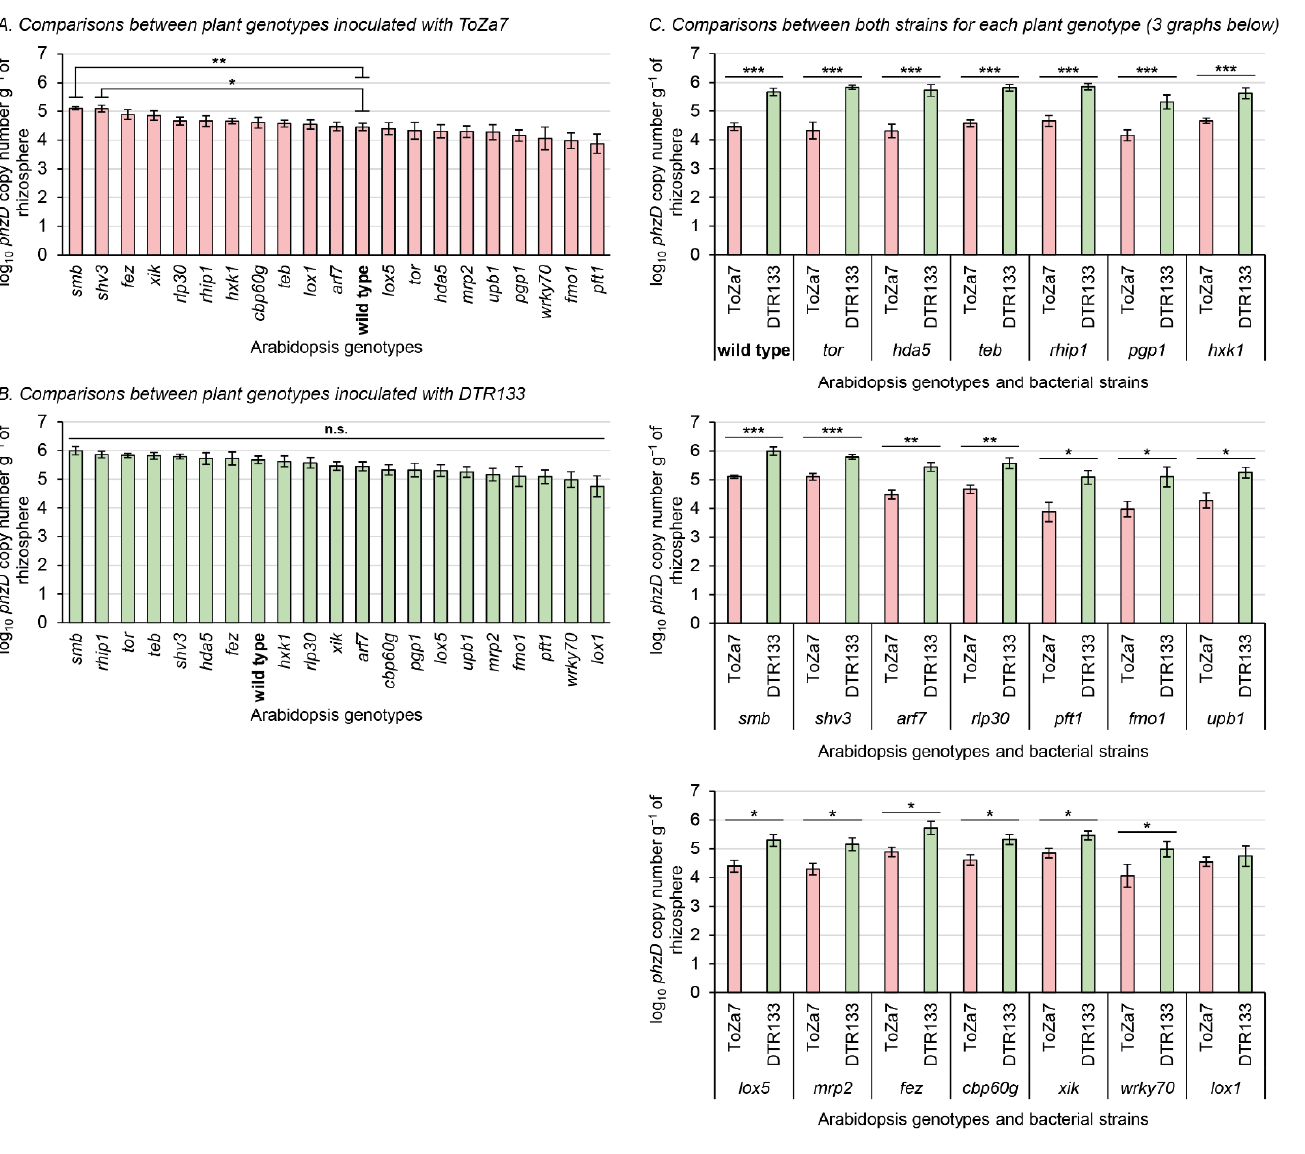
Figure 1. Rhizosphere colonization three weeks following bacterial inoculation with P . chlororaphis subsp. piscium strains ToZa7 and DTR133 for 21 A . thaliana genotypes. Asterisks refer to significant differences between groups. ( A ) and ( B ): nonparametric multiple test procedure for many-to-one comparisons [81], allowing the comparison of all mutants against the wild type. ( C ): Wilcoxon–Mann–Whitney tests. * p -value < 0.05; ** p -value < 0.01; *** p -value < 0.001; n.s.: non-significant. Bars indicate standard errors ( n = 10).